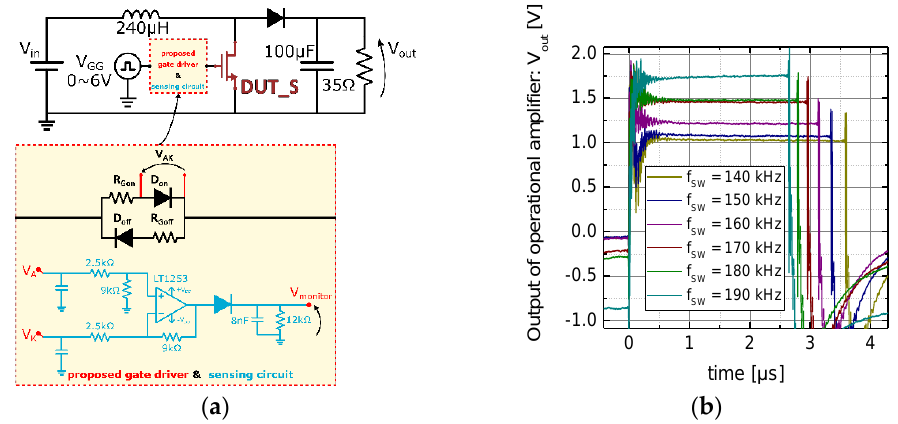
Figure 8. ( a ) Circuit schematic of the prototyped step-up converter based on Schottky-gate p-GaN HEMT and gate driver with the sensing differential amplifier; ( b ) output waveforms of the sensing circuit at different switching frequencies.